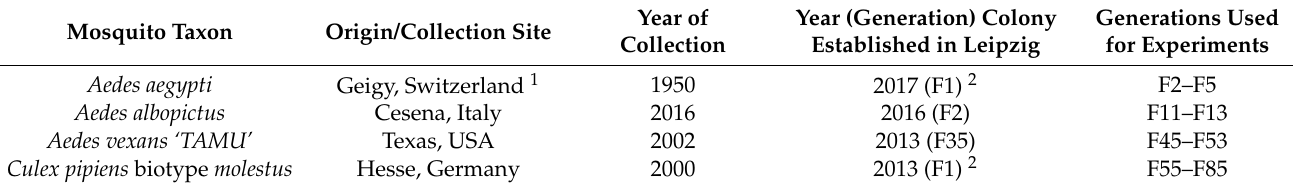
Table 1. Taxa and origin of mosquitoes used in the infection